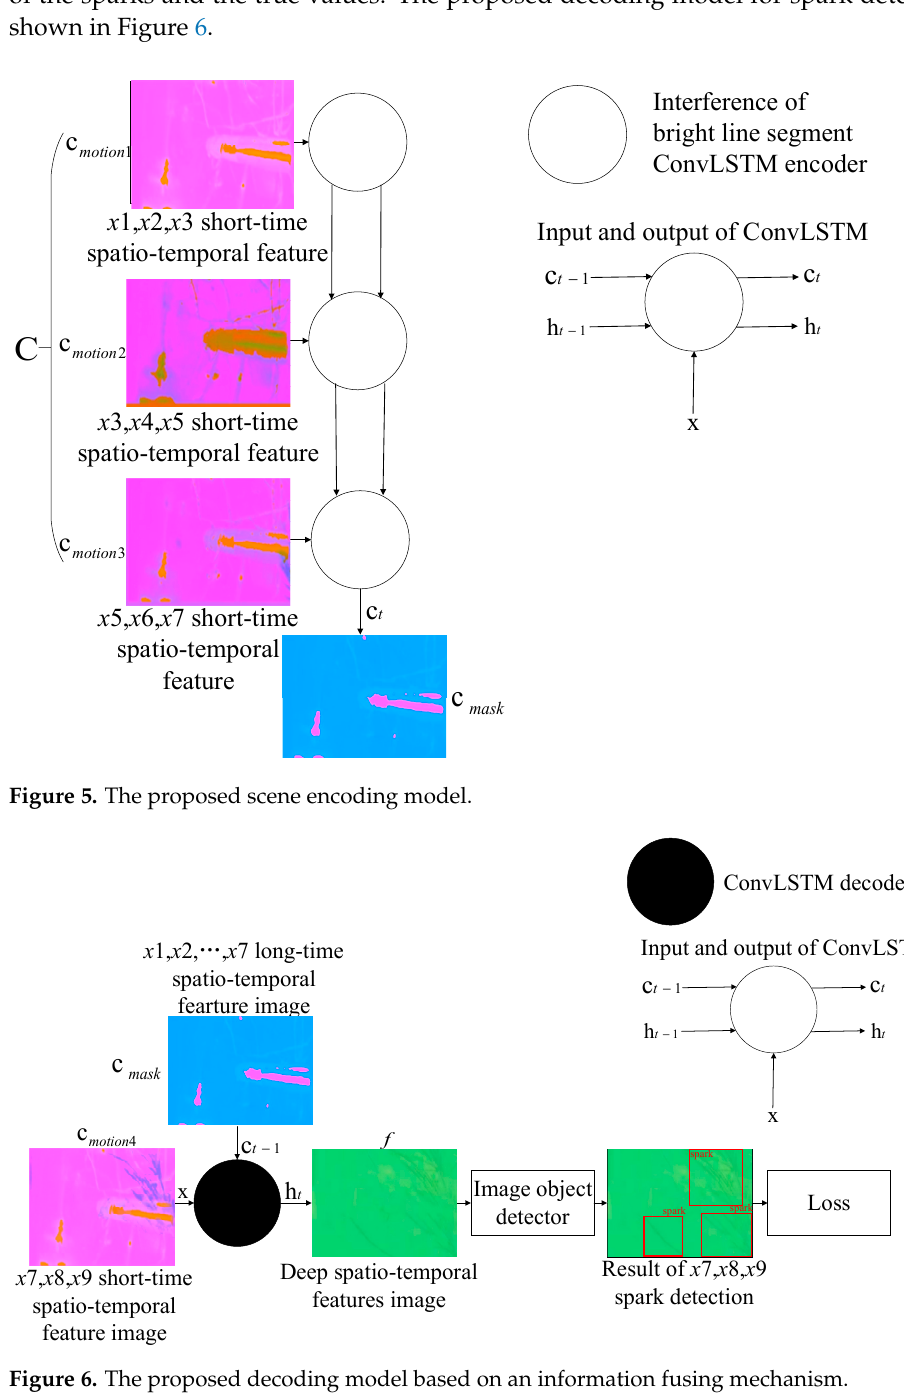
Figure 6. The proposed decoding model based on an information fusing mechanism. The flow chart of spark detection is shown in Figure